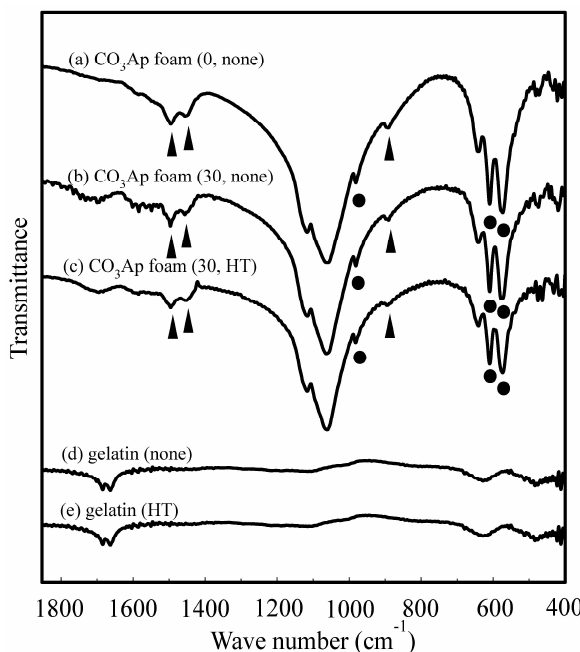
Figure 4. Fourier-transform infrared spectroscopy spectra of CO 3 Ap foams: ( a ) CO 3 Ap foam (0, none); ( b ) CO 3 Ap foam (30, none); ( c ) CO 3 Ap foam (30, HT); ( d ) gelatin without heat treatment; and ( e ) gelatin with heat treatment at 155 °C under vacuum for 4 h. Triangles; correspond to B-type CO 3 Ap peaks (1455, 1410 and 875 cm − 1 ), Black circles; correspond to phosphate bands peaks (980–1100 and 560–600 cm − 1 ).